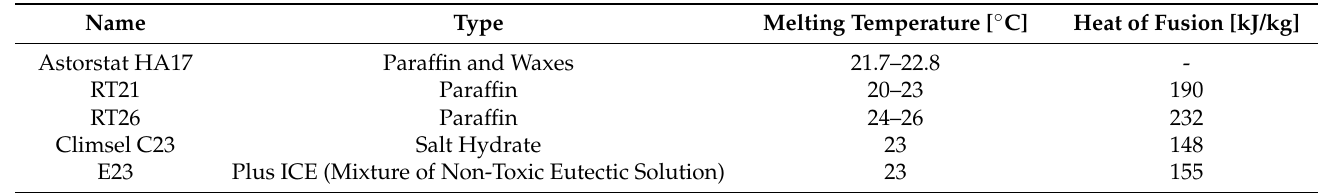
Table 1. Properties of typical commercial PCMs [18–20].